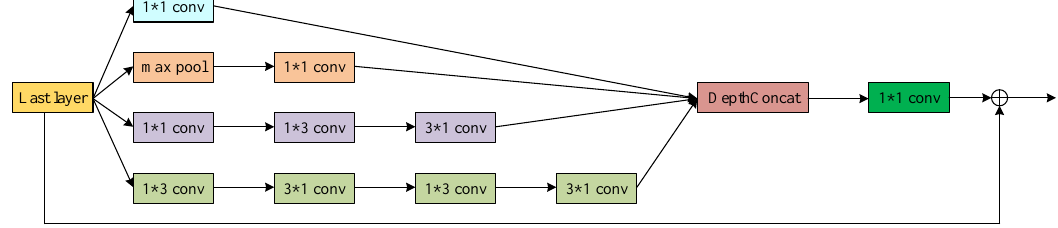
Figure 3. The modified inception module used in the proposed lung parenchyma segmentation